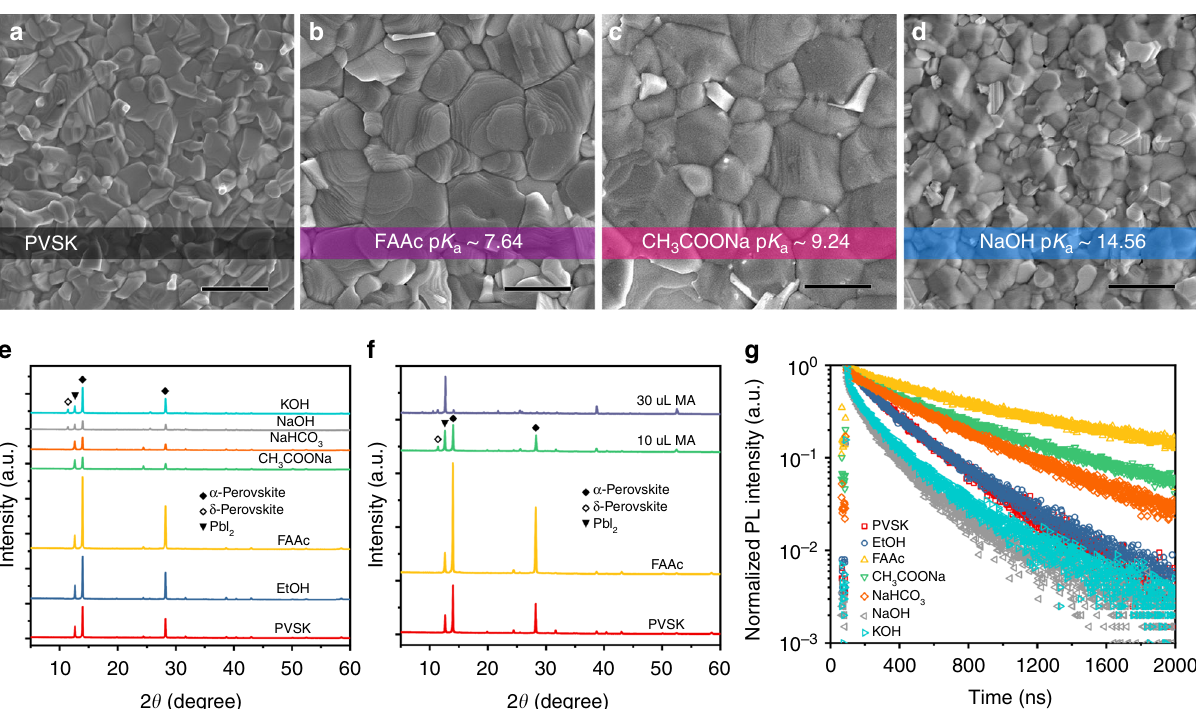
Fig. 2 Morphology, phase, and carrier lifetime analysis. SEM images for the perovskite fi lms deposited on SnO 2 -coated ITO glass prepared from the precursor solution with ( a ) no additive, ( b ) FAAc, ( c ) CH 3 COONa, and ( d ) NaOH ethanol solution, with a scale bar of 1 μ m. e X-ray diffraction (XRD) pattern for the perovskite fi lms deposited on SnO 2 -coated ITO glass prepared from the precursor solution with different alkaline additives. f XRD pattern for the perovskite fi lms with NO additive, MA, and FAAc ethanol solution. g Time-resolved photoluminescence (TRPL) spectra for the perovskite fi